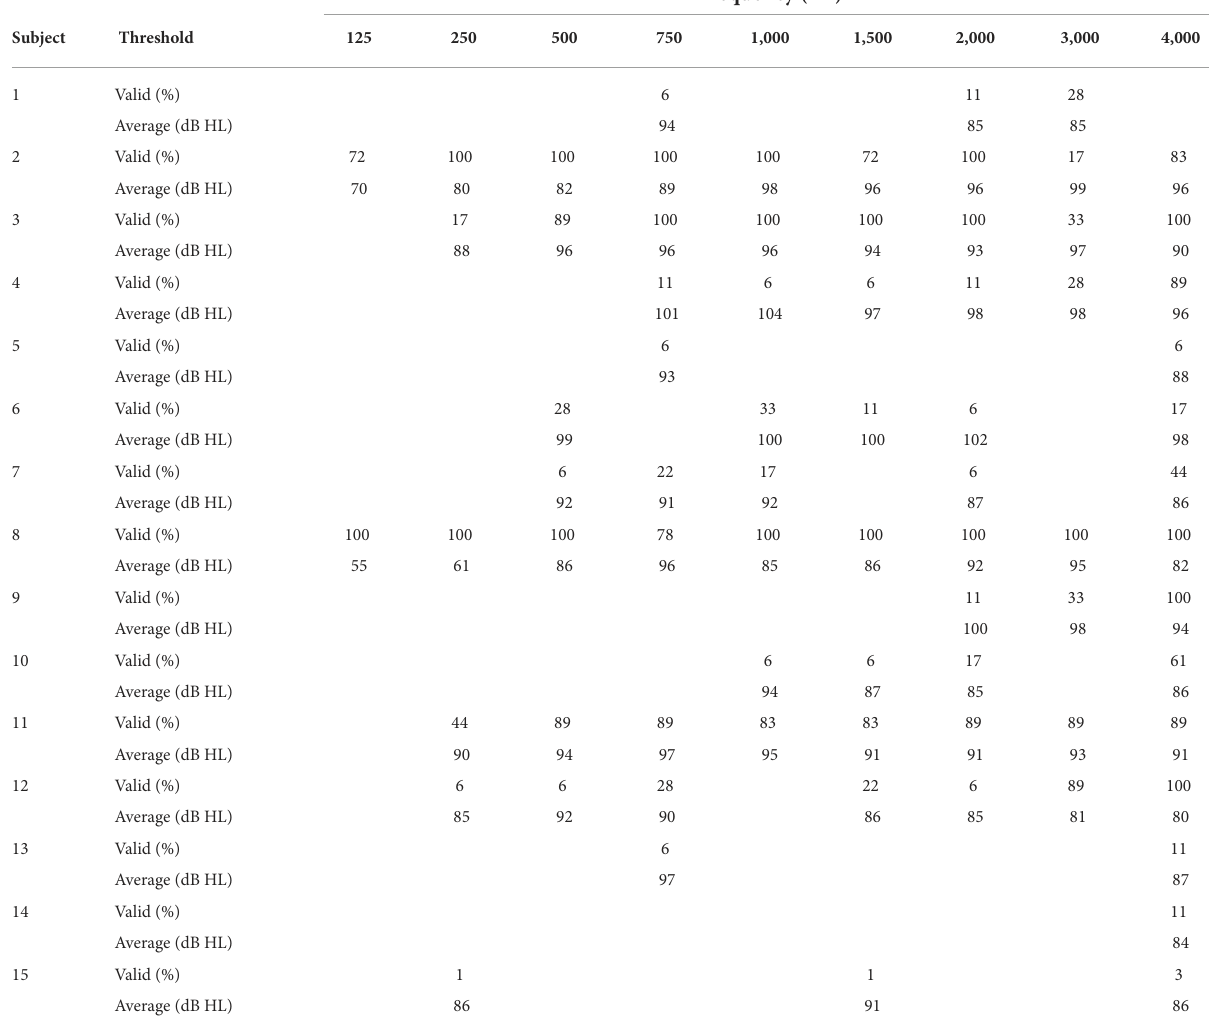
TABLE 1 Summary of each subject’s ECochG threshold ( N =